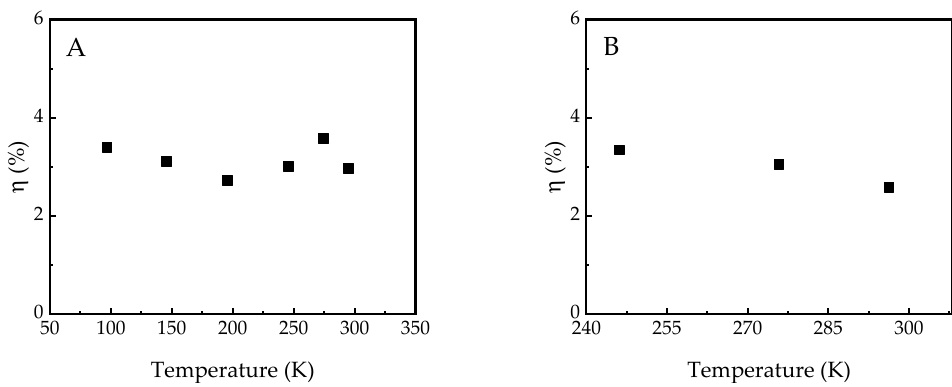
Figure 2. Thermal rectification coefficient as a function of temperature of different samples. ( A ) First Si/PA nanowire sample. ( B ) Second sample after focused ion beam cutting [25].